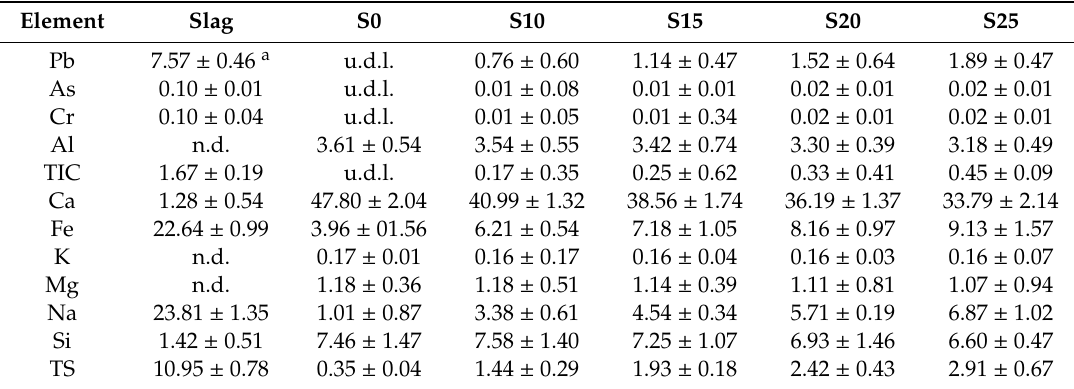
Table 2. Composition of the slag and solidified samples (in weight